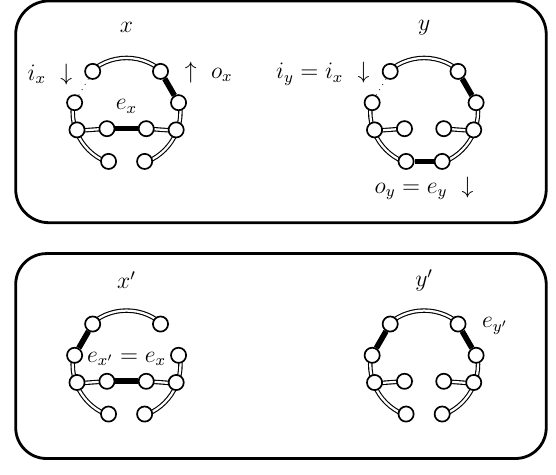
U y . U y . Figure 12. Case 4. b .i when B fails and s y / ∈ ∈